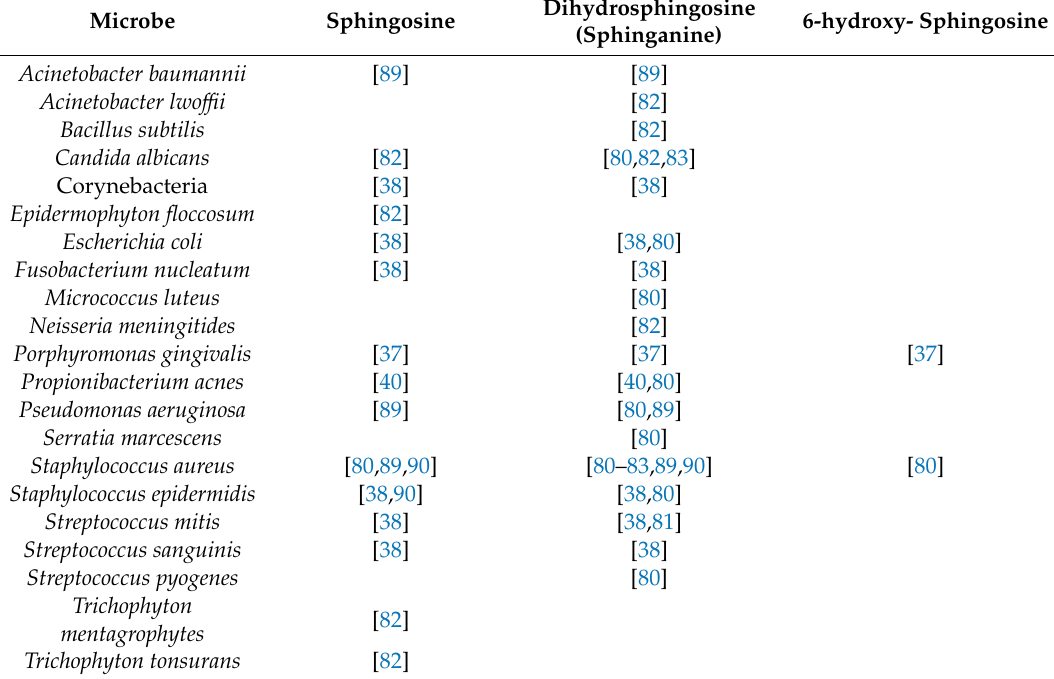
Table 3. Innate free sphingoid bases, naturally occurring on skin and mucosal membranes, exhibit antimicrobial activity against a variety of opportunistic bacteria, viruses, and fungi. These data are summarized from multiple studies; however, huge variability in reporting of AML activity precludes the compilation of detailed concentrations into a single chart. Readers are referred to individual citations for specific concentration